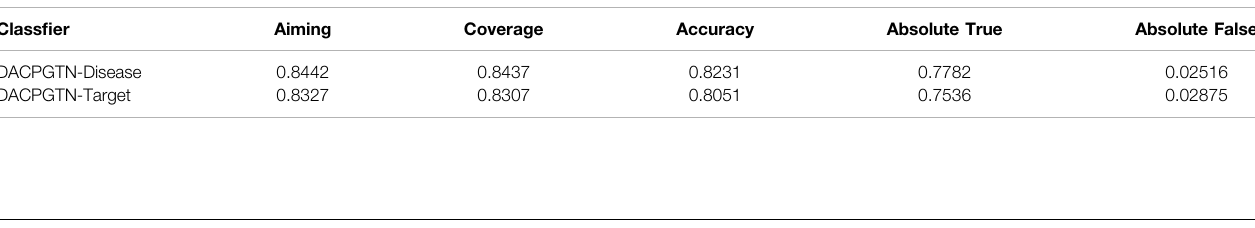
TABLE 6 | New drugs prediction experiment results. Interactions Aiming